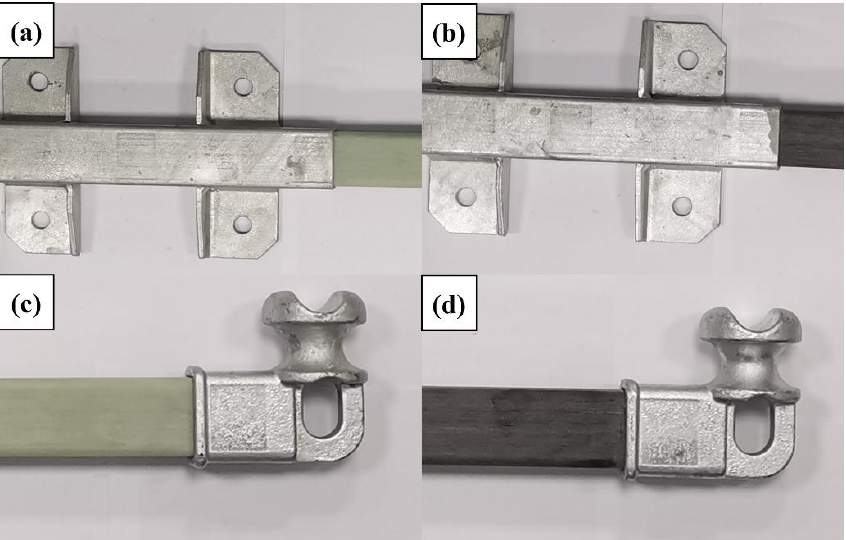
Figure 9. End fitting connection ( a , b ) and wire fitting connection ( c , d ).